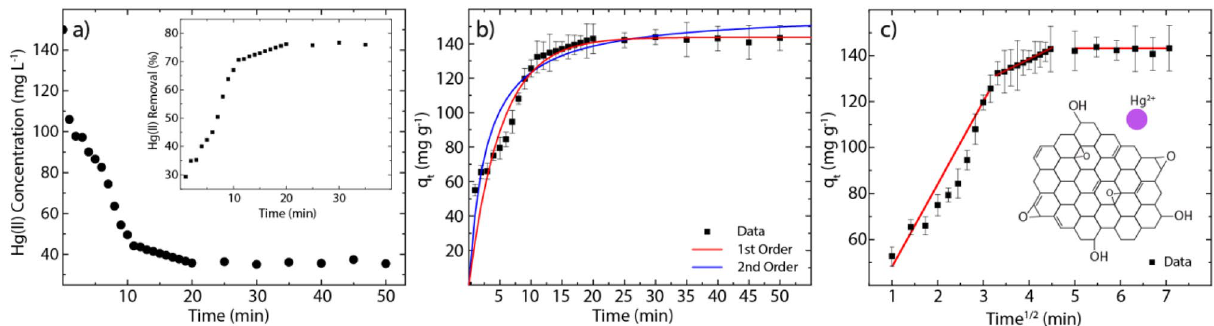
Figure 2. Kinetics investigation and particle diffusion. ( a ) Hg(II) adsorption kinetics of rGO under the Hg(II) initial concentration of 150 mg L −1 . Inset shows the removal percentage. ( b ) The pseudo-first and pseudo- second-order kinetic plot for the adsorption (Hg(II) concentration 150 mg L −1 ). ( c ) Intraparticle diffusion plot showing three regions of linearity (Hg(II) concentration 150 mg L −1